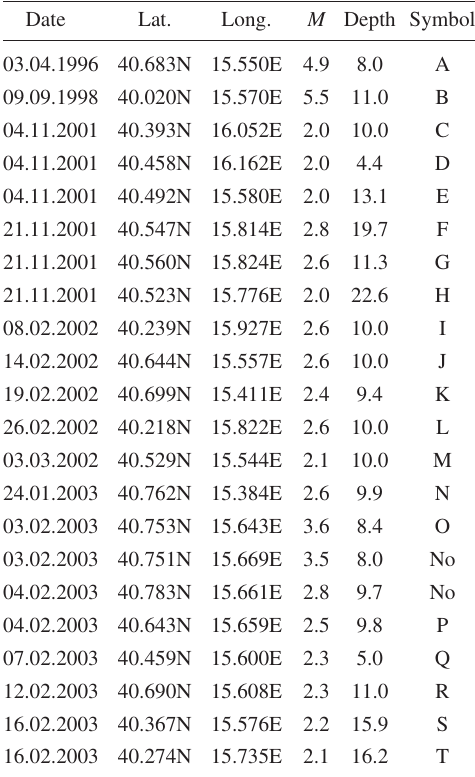
Table I. All seismic events occurring in Val d’Agri region within the co-ordinates of 40.0-40.8N and 15.3-16.1E and the foci not deeper than 25 km with possible temporal relations to the recorded flux anomalies; focal depth in km (INGV Bulletin). Fig- ure 2 show the epicentre with the symbols. Date Lat. Long. M Depth